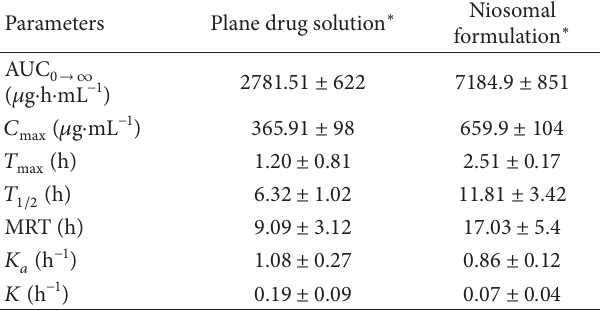
Table 5: Pharmacokinetic parameters of TDF in rats after oral administration of a single dose of 95 mg/kg as plane drug solution and niosomal formulation.